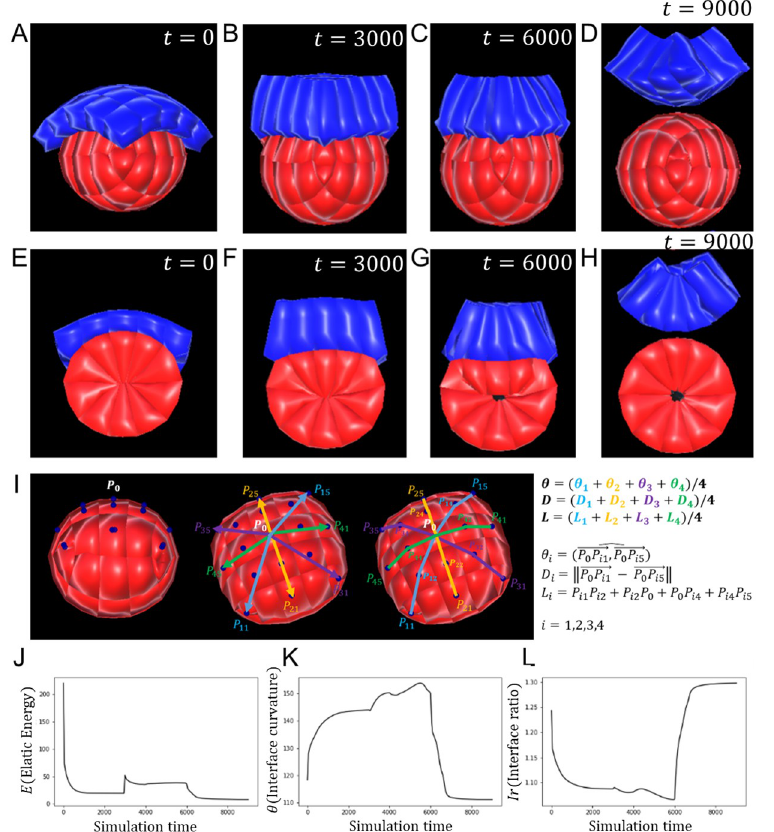
Fig 4. Trophectoderm morphogenesis regulates epiblast shape. A-D . 3D snapshots of the simulation of TE and EPI morphogenesis during mouse implantation, and the regulation of EPI shape, taken respectively at t = 0, 3000, 6000 and 9000. E-H . Corresponding 2D slices of the cell population at the same stages. (A,E) . The initial stage features a single layered TE with cuboidal cells resting upon the rosette-shaped epiblast. (B,F) . TE cells have transited to a columnar shape. (C,G) . The TE has folded by apical constriction of single cells. Concomitantly, lumenogenesis was initiated in the epiblast (the process starts at t = 4000). (D,H) . After adhesive links were broken between TE and EPI, the EPI bounces back to its near spherical shape. I . Definitions of the metrics used to evaluate the model, involving the curvature θ , TE/EPI interface diameter D , TE/EPI interface length L , and interface ratio L / D . J . Plot of the population’s elastic energy E . Discontinuities mark the start of new morphological events at t = 0, 3000, 4000, and 6000). After removal of the TE, E falls closer to zero than ever before, meaning that cells are closer to their resting stage, hence less externally constrained. K . Plot of the interface curvature θ . During TE morphogenesis, θ rises towards a flat angle, then sharply drops when the TE is removed. L . Plot of the interface ratio L / D . During TE morphogenesis, the interface curvature decreases towards 1, then sharply increases when the TE is removed. Values of the equation parameters: J EPI = J TE = 2.5, λ med = λ χ = 2, ρ = 1, d =